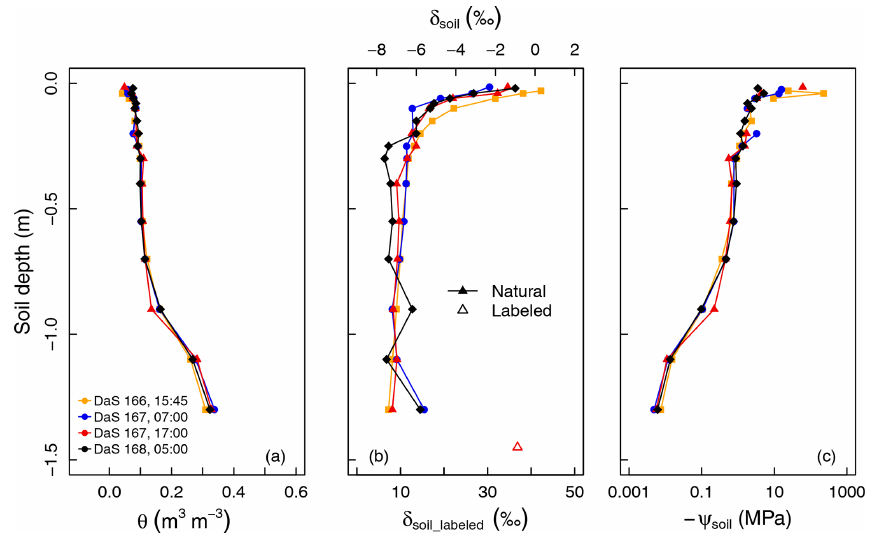
Figure 2. (a) Measured soil volumetric water content ( θ ), (b) oxygen isotopic composition ( δ soil ), and (c) calculated soil matric potential ( ψ soil ) profiles during the sampling period.